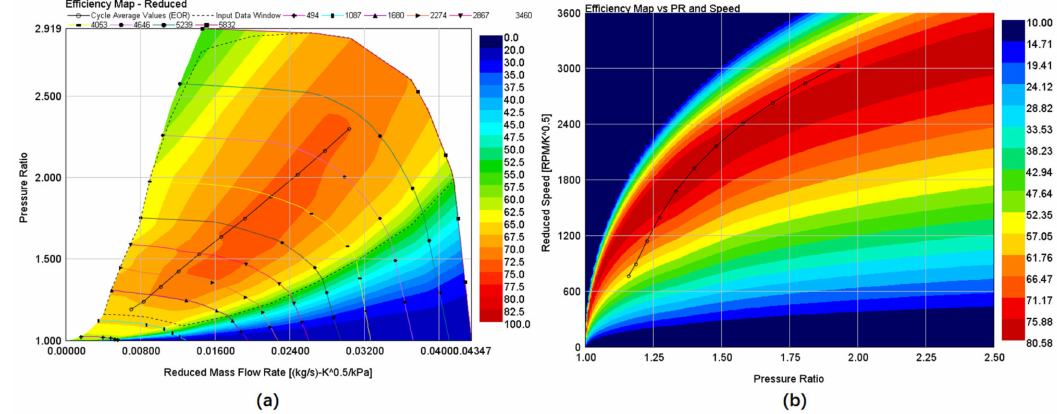
Figure 2. Operation trajectories of the turbocharger with the engine: ( a ) The compressor and ( b ) the